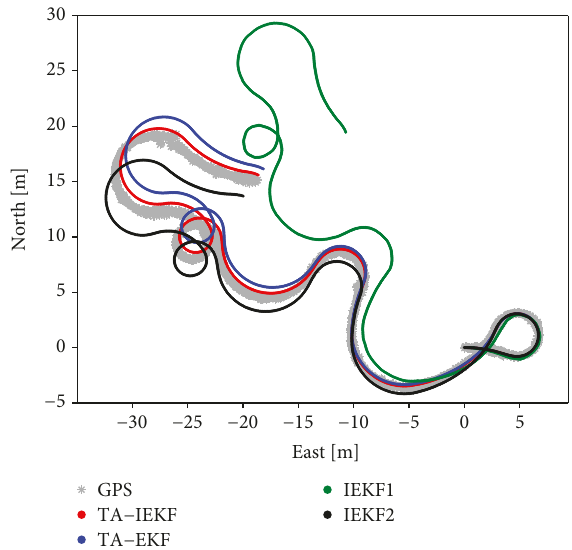
Figure 8: Results of dead reckoning with knowledge of ICRs. “ GPS ” stands for the outputs of GPS, “ IEKF1 ” stands for the terrain adaptive odometry whose ICRs are obtained using IEKF with small Q , “ IEKF2 ” stands for the terrain adaptive odometry whose s , “ TA-EKF ” stands for ICRs are obtained using IEKF with large Q s the terrain adaptive odometry whose ICRs are obtained using TA-EKF, and “ TA-IEKF ” stands for the terrain adaptive odometry whose ICRs are obtained using